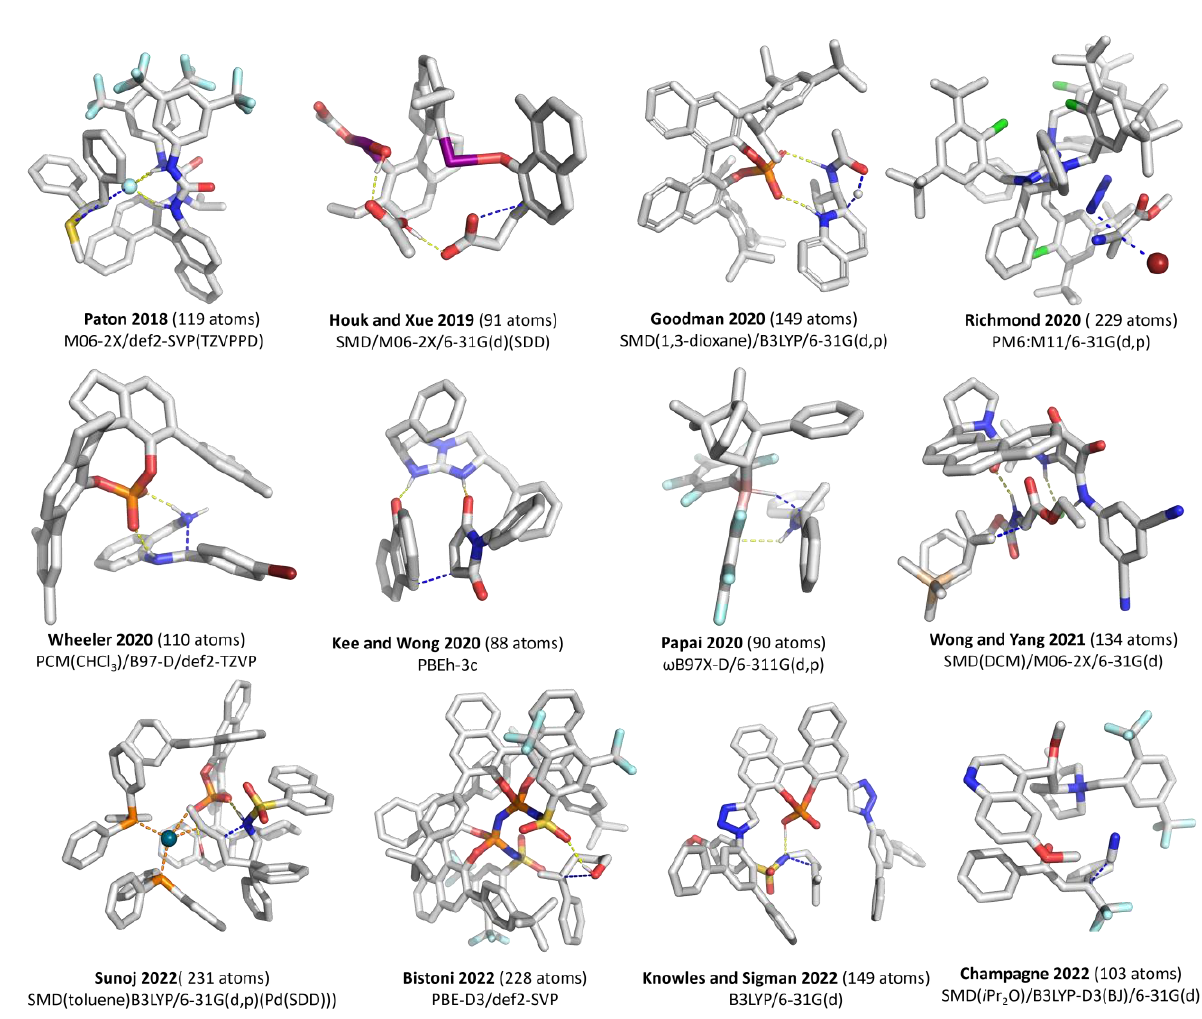
Figure 2. Selected examples of organocatalysts TS structures and their level of theory for geometry optimization. Yellow Dash line: hydrogen bond. Blue Dash line: key bonds in TS. Three-dimensional representations are generated from coordinates given in the cited references: Paton 2018 [29]; Houk and Xue 2019 [30]; Goodman 2020 [31]; Kee and Wong 2020 [32]; Richmond 2020 [33]; Wheeler 2020 [34]; Papai 2020 [35]; Wong and Yang 2021 [36]; Sunoj 2022 [28]; Bistoni 2022 [37]; Champagne 2022 [38]; Knowles and Sigman 2022 [39].